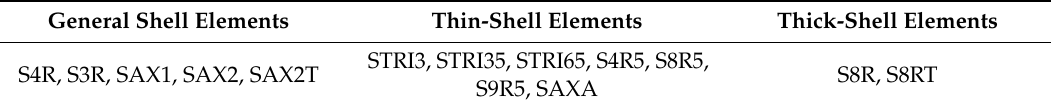
Table 1. Abaqus shell element